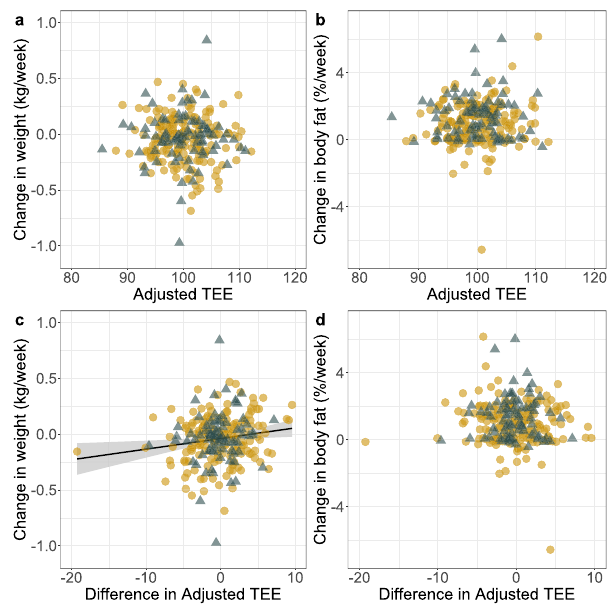
Fig. 2 Relationship between adjusted total energy expenditure (TEE), the difference in adjusted TEE between measurements and changes in body weight and body fat percentage. Relationship between adjusted TEE (MJ/ d; adjusted for FFM, FM, age, and sex) at the fi rst measurement and a changes in body weight and b changes in body fat percentage until the second TEE measurement, and the relationship between the difference in adjusted TEE between measurements (i.e., adjusted TEE2 – adjusted TEE1), and c changes in body weight (linear regression line is shown and shaded area indicates 95% con fi dence interval) and d changes in body fat percentage until the second TEE measurement ( N = 267 subjects aged 20 – 60 years; yellow circles present females and gray triangles present